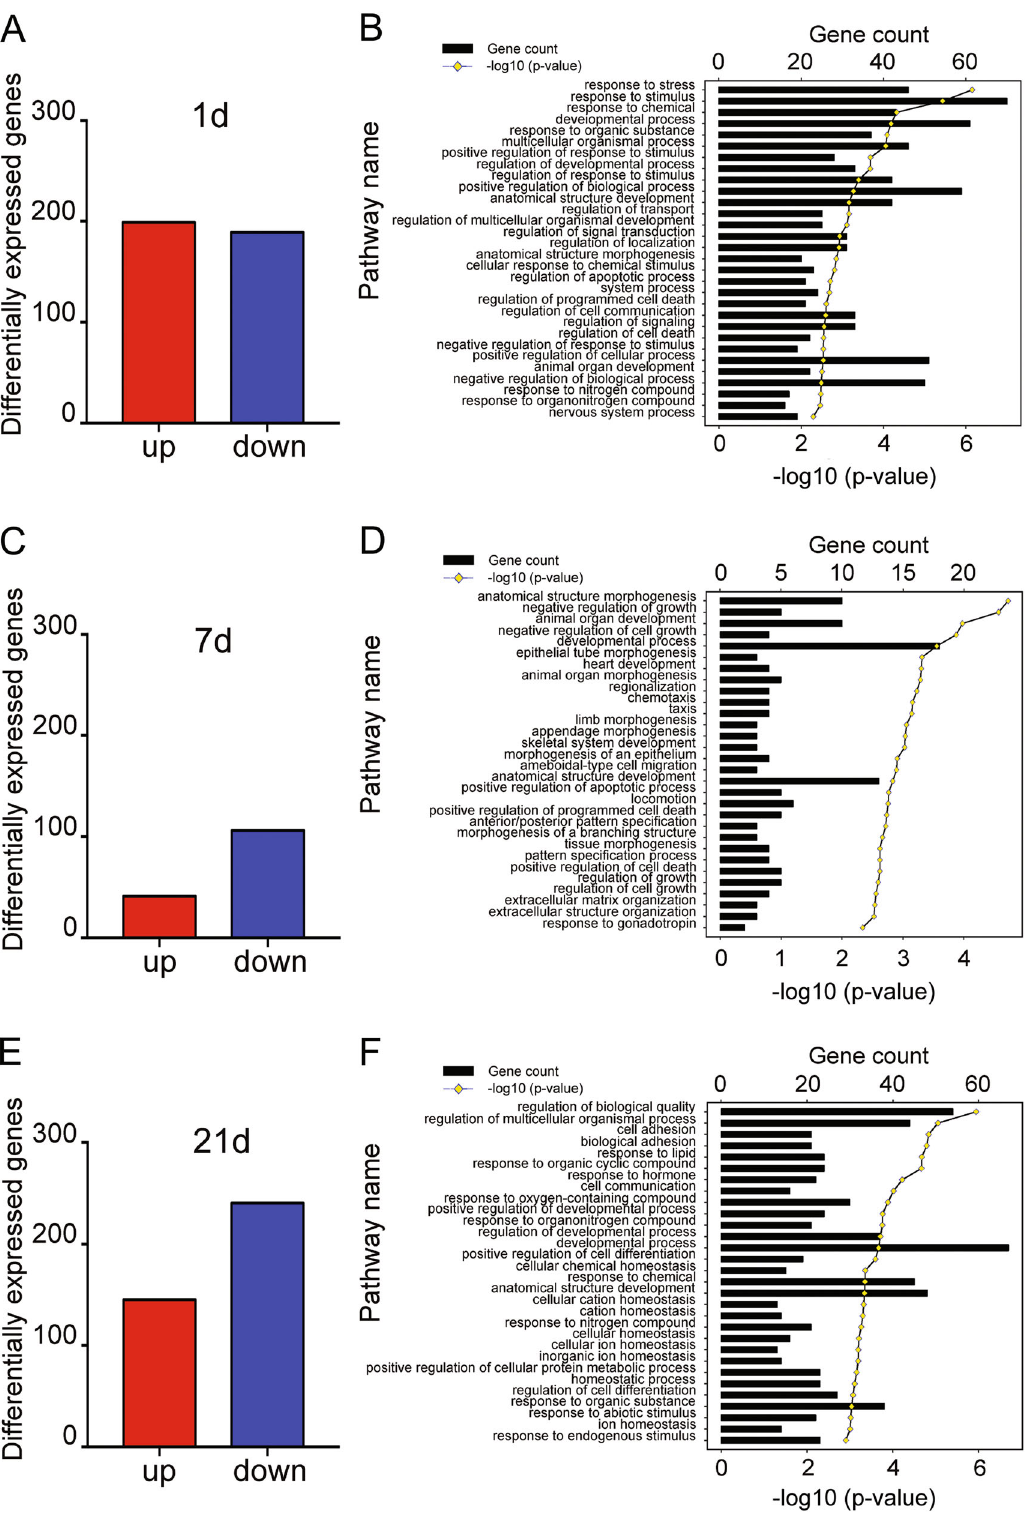
Fig. 3 Functional annotations of DEGs in the pup hippocampus following CH. A , C , E Bar graphs of DEGs in the P1, P7, and P21 rat pup hippocampus following CH. B , D , F Most signi fi cantly enriched groups for the DEGs relating to biological process by GO annotations. The signi fi cance of enrichment is expressed as a − log10 ( P